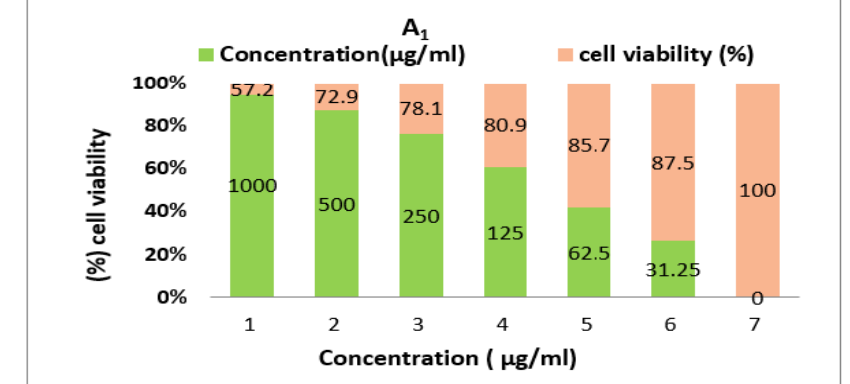
Fig. 11. The relationship of the percentage of inhibition with the concentration of (A 1 )